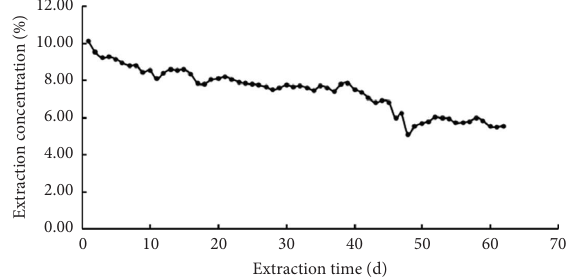
Figure 14: Te net volume change curve of